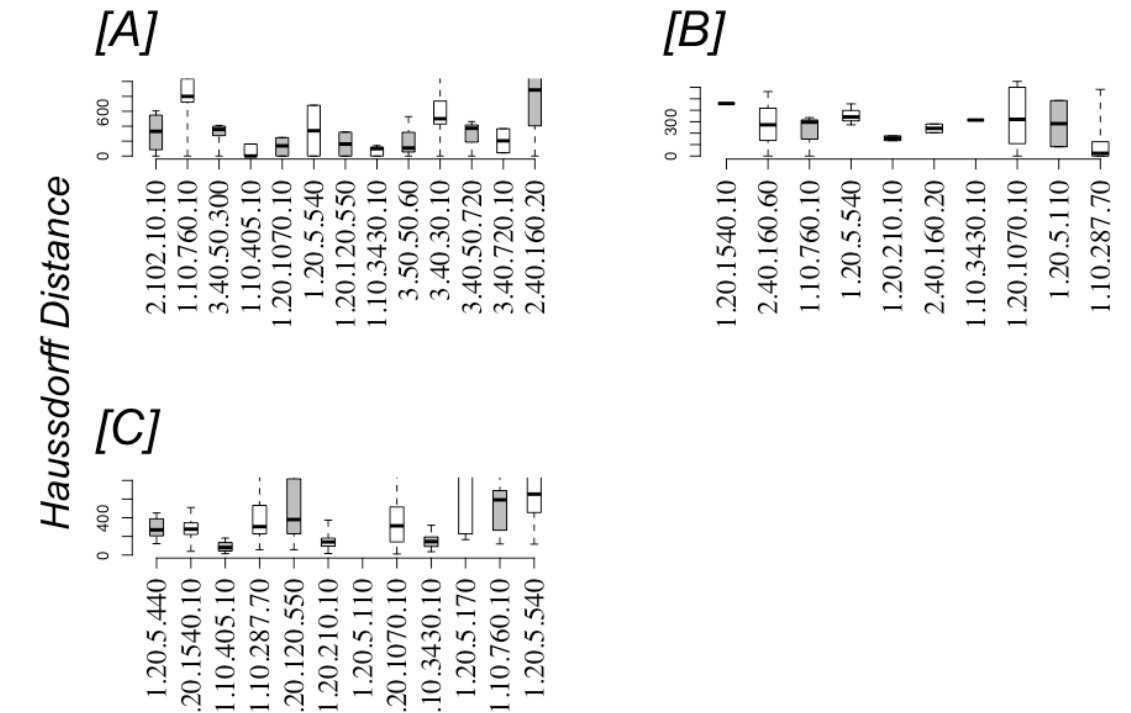
Figure 5. Geometrical differences between globular and transmembrane proteins. The Haussdorff distance (see Methods) was calculated for each protein structure present in the indicated CATH classes on the x-axis for globular ( A ) and transmembrane ( B ). This comparison was conducted also for pairs of globular and transmembrane proteins with the same CATH class with alpha helical structure ( C ). The differences are plotted as boxes, where the median is presented as a horizontal line within the box and the horizontal lines away from the box denote the minimum and maximum values of these distances per CATH class. To facilitate the visualization of these trends, the y-axis value range was ≤ 700.